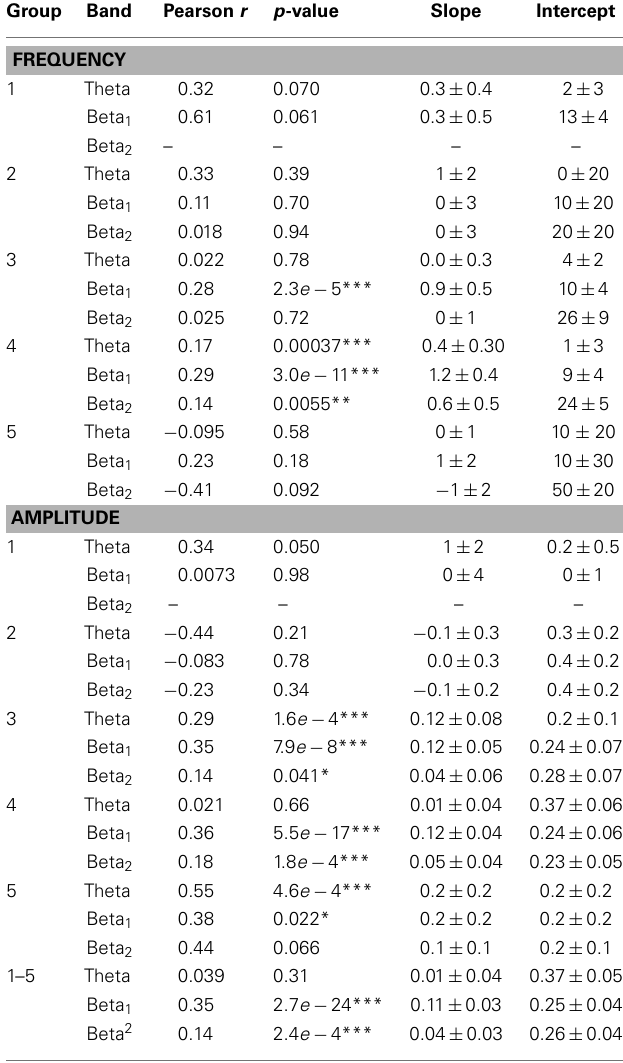
Table 2 | Correlation coefficients, the corresponding p -values, slopes, and intercepts for linear fits of theta, beta 1 , and beta 2 peak parameters vs. alpha peak